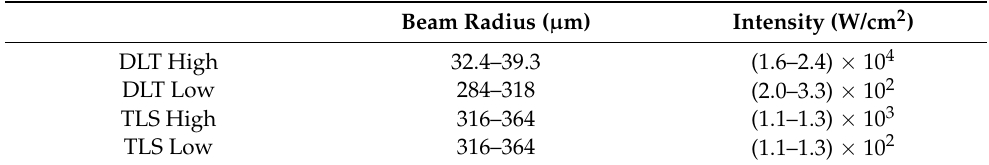
Figure 12 . Experimentally determined cooling efficiencies versus wavelength from DLT measure- ments in Yb:YLF at high and low intensities. The pump power was 0.8 W for all the measurements, and beam size was varied to reach the intensities shown in Table 1. Table 1. Pump beam radius (half-width at 1/e 2 intensity) and intensity values used for the measure- ments presented in Figures 11 and 12. Entries indicate the small variations of intensity at multiple wavelengths for each intensity